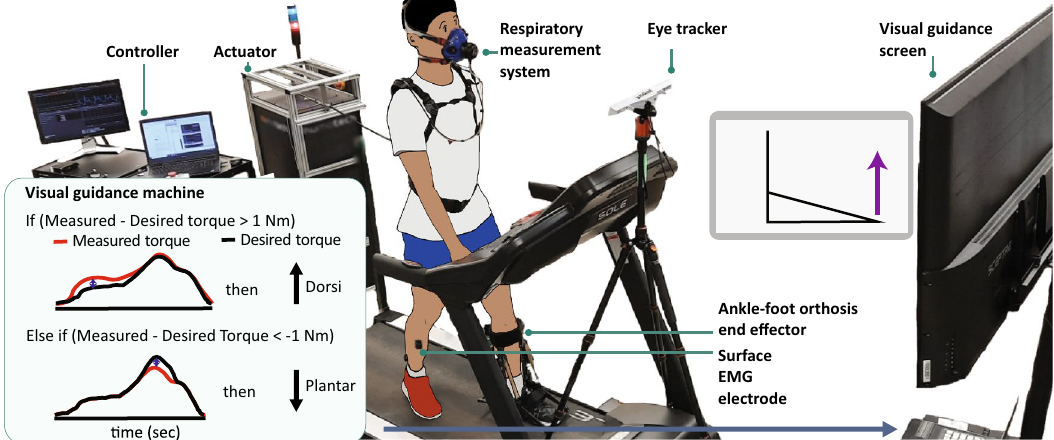
Figure 1. Experimental setup of visual guidance to facilitate the wearable robot use. The participant walked on a treadmill with a unilateral ankle–foot orthosis while being measured for respiratory rate, electromyography (EMG), and pupil diameter. The subject received visual guidance from software with a graphical user interface. The visual guidance presented an animation with an arrow indicating the error between the desired and actual torque. A positive “Up” and a negative “Down” arrow indicated that the user did not provide enough actual dorsiflexion torque and plantarflexion torque,